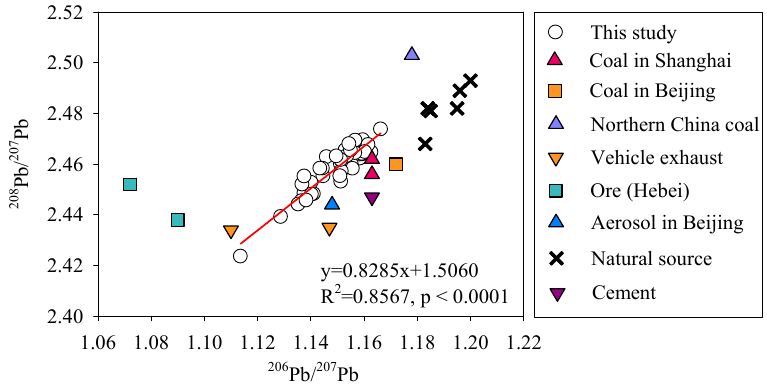
Figure 5. Isotopic composition ( 208 Pb / 207 Pb versus 206 Pb / 207 Pb) in sediment.